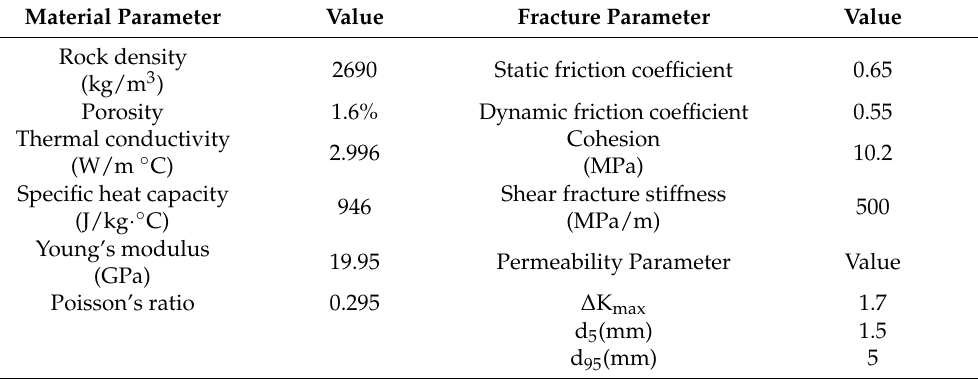
Table 4. Parameter values used for generating in the THM model.